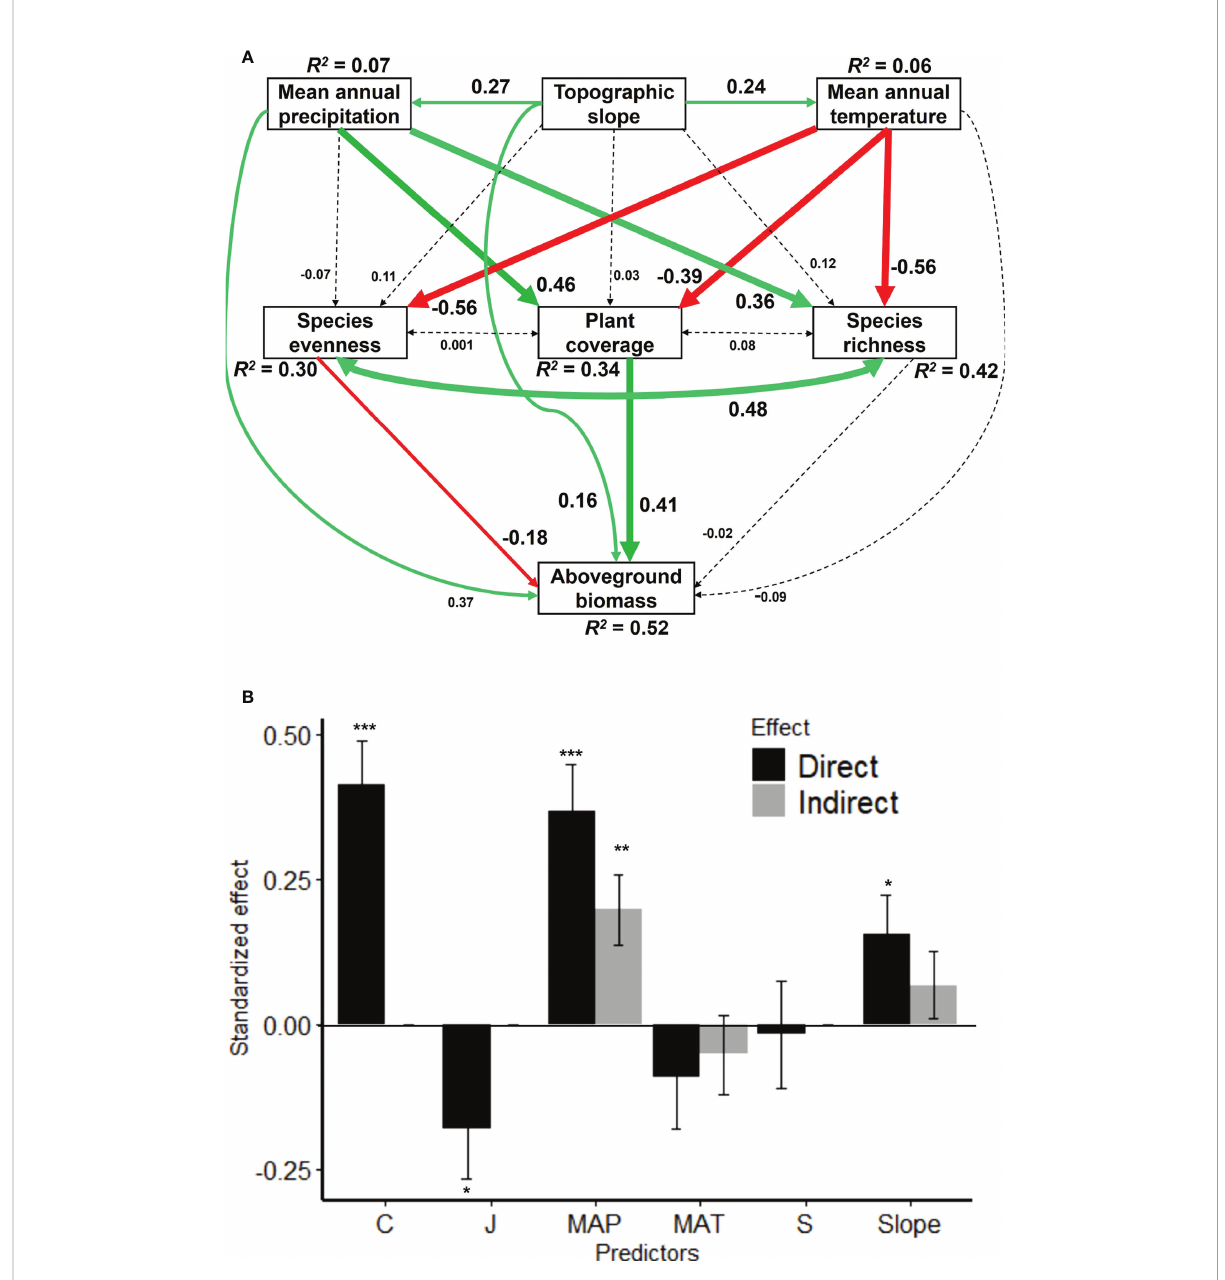
FIGURE 4 Structural equation model (A) for linking the direct and indirect effects of topographic slope and climatic factors (MAT and MAP) on aboveground biomass (AGB) via plant coverage, species richness, evenness in large-scale scale grasslands dominated by Leymus chinensis in northern China. Solid arrows represent signi fi cant ( P < 0.05) effects and dashed arrows represent non-signi fi cant effects ( P > 0.05). Red arrows represent negative effects while green arrows represent positive effects with a standardized value near each arrow. R 2 value associated with the response variable indicates the proportion of variation explained by predictors. Bar chart comparison of the direct and indirect effects of predictors on AGB (B) . See Table S3 for the summary. Model- fi t statistic: CFI = 0.999; GFI = 0.996; SRMR = 0.034; Chi-square test statistic = 1.344 with P -value = 0.248 and degrees offreedom = 1. Signi fi cance levels (B) : ***P < 0.001; **P < 0.01; *P < 0.05. MAP, mean annual precipitation; MAT, mean annual temperature; C, plant coverage; J, species evenness; S, species richness; and AGB, aboveground